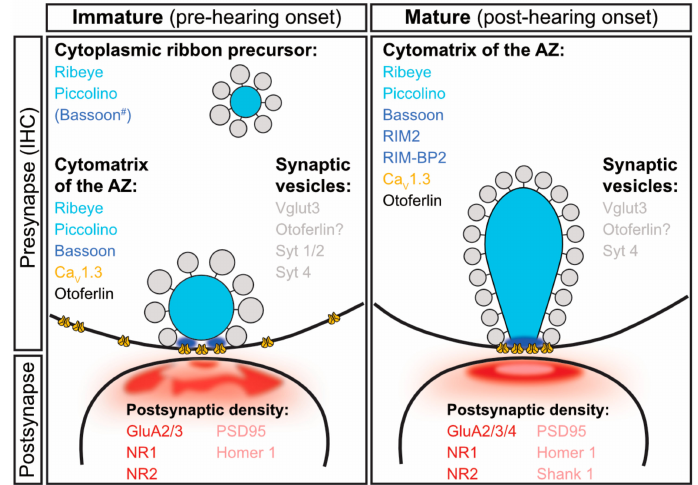
Figure 4. Molecular maturation of ribbon-type AZs. Molecular composition of a murine ribbon synapse between inner hair cells (IHCs) and spiral ganglion neurons (SGNs) and its di ff erential constitution during early postnatal development (prior to hearing onset) and in matured stages (after hearing onset). Along with the growth, membrane attachment and fusion of precursors, the establishment of a mature ribbon synapse involves the spatial confinement of its molecular components: Ca V s localize in tight clusters underneath the ribbon, multiple presynaptic densities merge to one single ribbon anchor and postsynaptically one continuous elongated postsynaptic density is formed that stabilizes a ring-like organization of AMPA receptors. A developmental switch in the regulation of presynaptic exocytosis is present in the downregulation of Synaptotagmin (Syt) 1 and 2, which are likely absent from mature ribbons. Here, the IHC-specific multi-C2-domain protein Otoferlin becomes responsible for the regulation of synaptic vesicle release in the early post-natal stages, despite expression from embryonic ages. (#) Bassoon is part of ribbon precursor spheres in the retina. The here illustrated divergence in the illustrated protein expression between immature and mature preparations does not necessarily reflect absence of expression in the young tissue per se but rather results from the current lack of experimental evidence from pre-hearing preparations. For more detailed information please refer to the respective parts in the text. Font color indicates association with the correspondingly colored pre- / postsynaptic